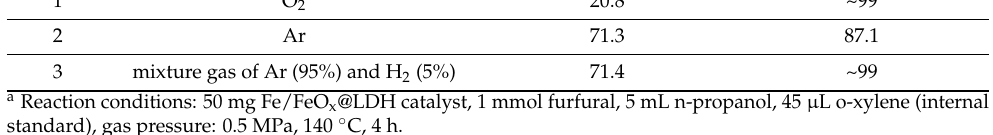
Figure 9. Possible reaction routes using Fe/FeOx@LDH, Fe/FeOx@LDH, and LDH as catalysts. Reproduced with permission from [34]. Copyright: Elsevier 2020. Table 4. Studies of oxidative condensation of furfural with n-propanol in different gas atmospheres a [34]. Entry Gas Atmosphere Furfural Conversion